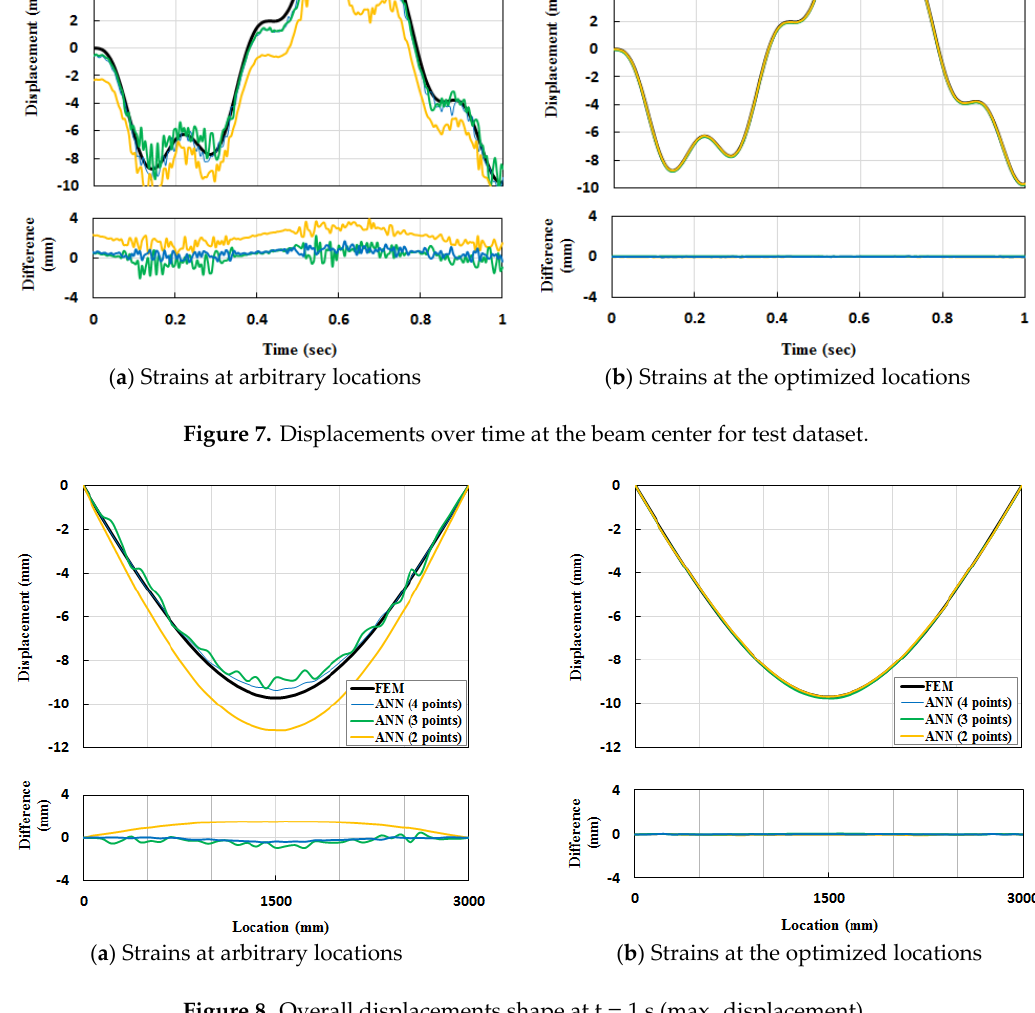
Table 4. Information for the bridge model.